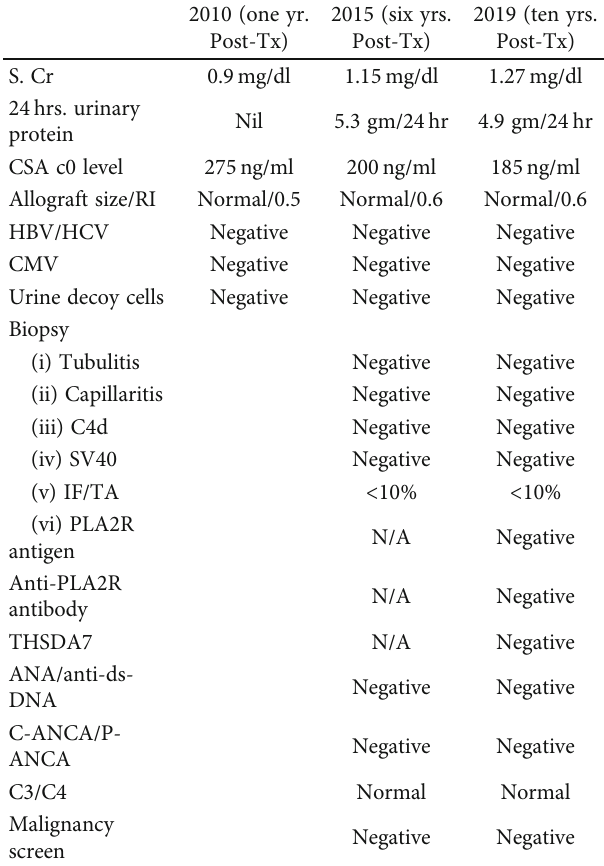
Table 1: Laboratory and biopsy fi ndings at 1, 6, and 10 years